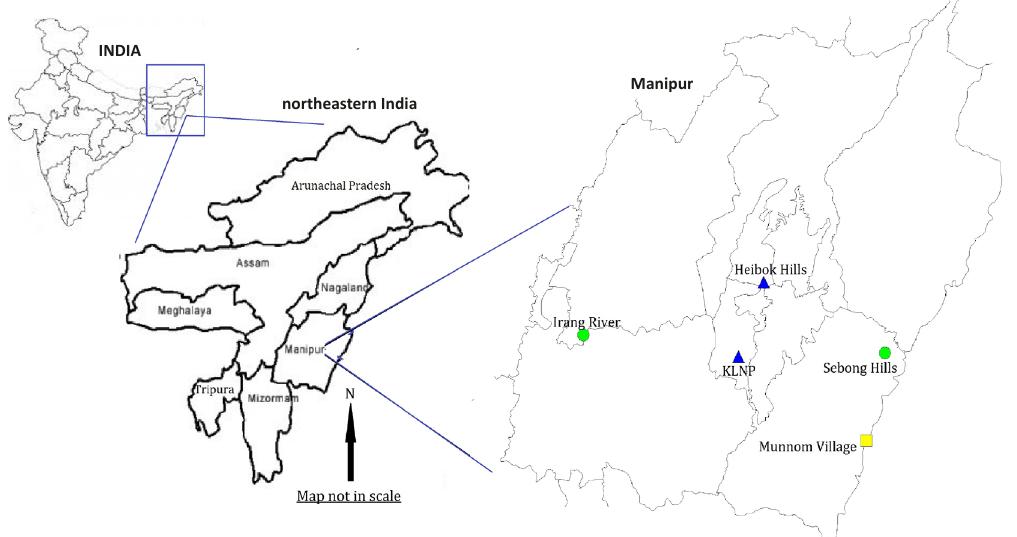
west.Figure 1. Map showing the localities of the recent sightings and older sightings (green circle) from Manipur. Blue Triangle shows the localities of C. i. uposathra and Yellow Square is of A. atkinsoni. (Prepared by: Jatishwor Singh Irungbam using DIVA-GIS